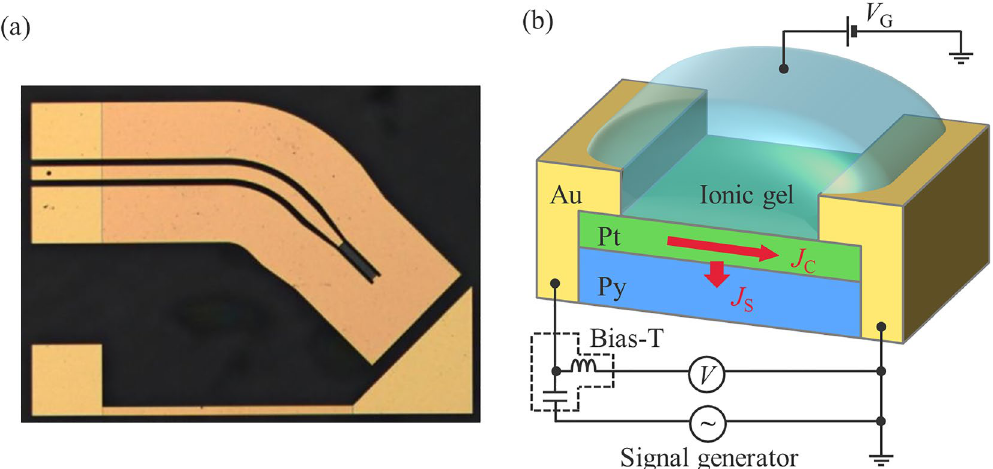
Figure 1. Structure of the gate-tunable ST-FMR device consisting of a Pt/Py bilayer. ( a ) Optical microscopic image of the ST-FMR device. ( b ) Schematic of the ST-FMR device and diagram of the ST-FMR measurement setup. Ultrathin Pt (1.2, 1.4 and 1.8 nm) is grown on Py (3 nm), and an ionic gel is coated onto the Pt. Gate voltages are applied via the ionic gel, enabling charge accumulation in the Pt. The experimental set-up measures the DC voltage produced across the device when applying an AC electric current, J C . The SHE in the Pt is modulated by gating, resulting in the modulation of the generated spin current, J S , by the